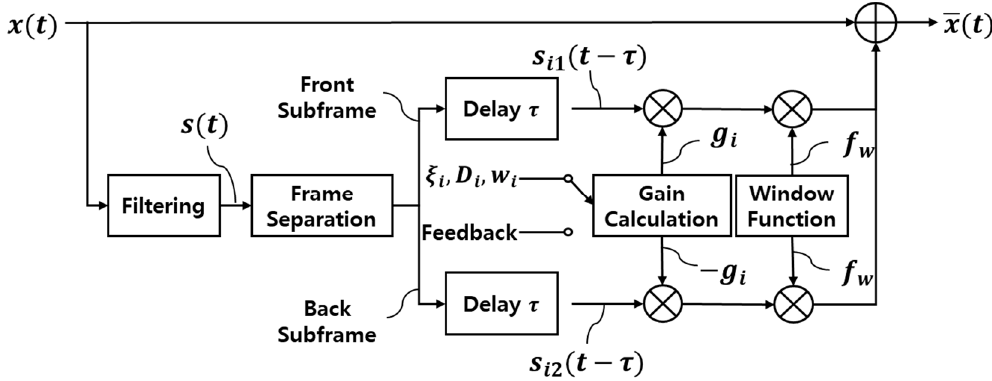
Figure 2. Watermark embedding procedure.